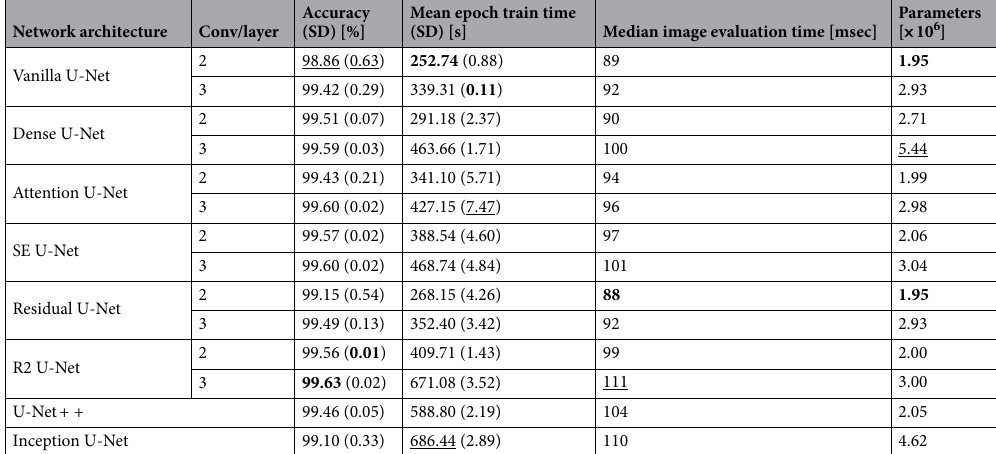
Table 4. Comparison of results for the AMD dataset. SD: standard deviation, s: seconds, SE: squeeze + excite, R2: recurrent-residual). The best and poorest results for each are annotated in bold and underline text respectively.